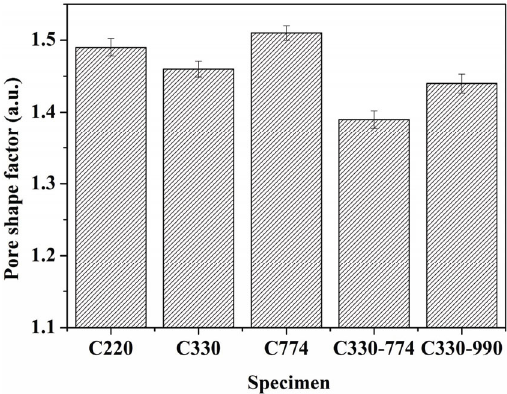
Fig. 3 Pore shape factor of porous alumina ceramics.